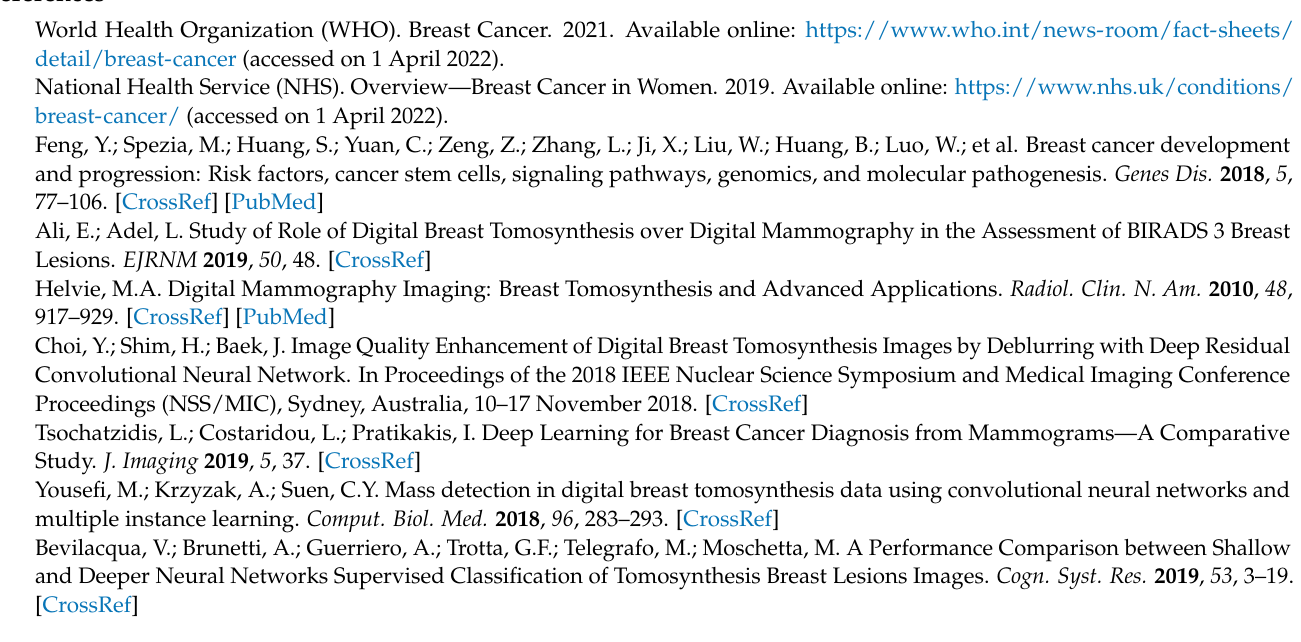
tails. Table S2. AlexNet’s architectural details. Table S3. GoogleNet layers. Table S4. MobileNetV2 layers. Table S5. Comparison between the six DL models on Dataset 1 after pre-processing in terms of Accuracy with a 95% Confidence Interval (CI) and Run-time in seconds. Table S6. Comparison between the six DL models on Dataset 2 in terms of Accuracy with a 95% Confidence Interval (CI) and Run-time in seconds. Table S7. Comparison between the six DL models on Dataset 1 and Dataset 2 in terms of Accuracy with a 95% Confidence Inter-val (CI) and Run-time in seconds. Table S8. Comparison between the six DL models on Dataset 2 and Dataset 3 in terms of Accuracy with a 95% Confidence Inter-val (CI) and Run-time in seconds. Figure S1. For SGDM optimizer (a) Training 64, (d) Training Loss on Batch size: 64, (e) Training Accuracy on Batch size: 512, (f) Training Loss on Batch size: 512. Figure S2. For Adam Optimizer (a) Training Accuracy on Batch size: 32, (b) Train-ing Loss on Batch size: 32, (c) Training Accuracy on Batch size: 64, (d) Training Loss on Batch size: 64, (e) Training Accuracy on Batch size: 512, (f) Training Loss on Batch size: 512. Figure S3. For RMSProp (a) Training Accuracy on Batch size: 32, (b) Training Loss on Batch size: 32, (c) Training Accuracy on Batch size: 64, (d) Training Loss on Batch size: 64, (e) Training Ac-curacy on Batch size: 512, (f) Training Loss on Batch size: